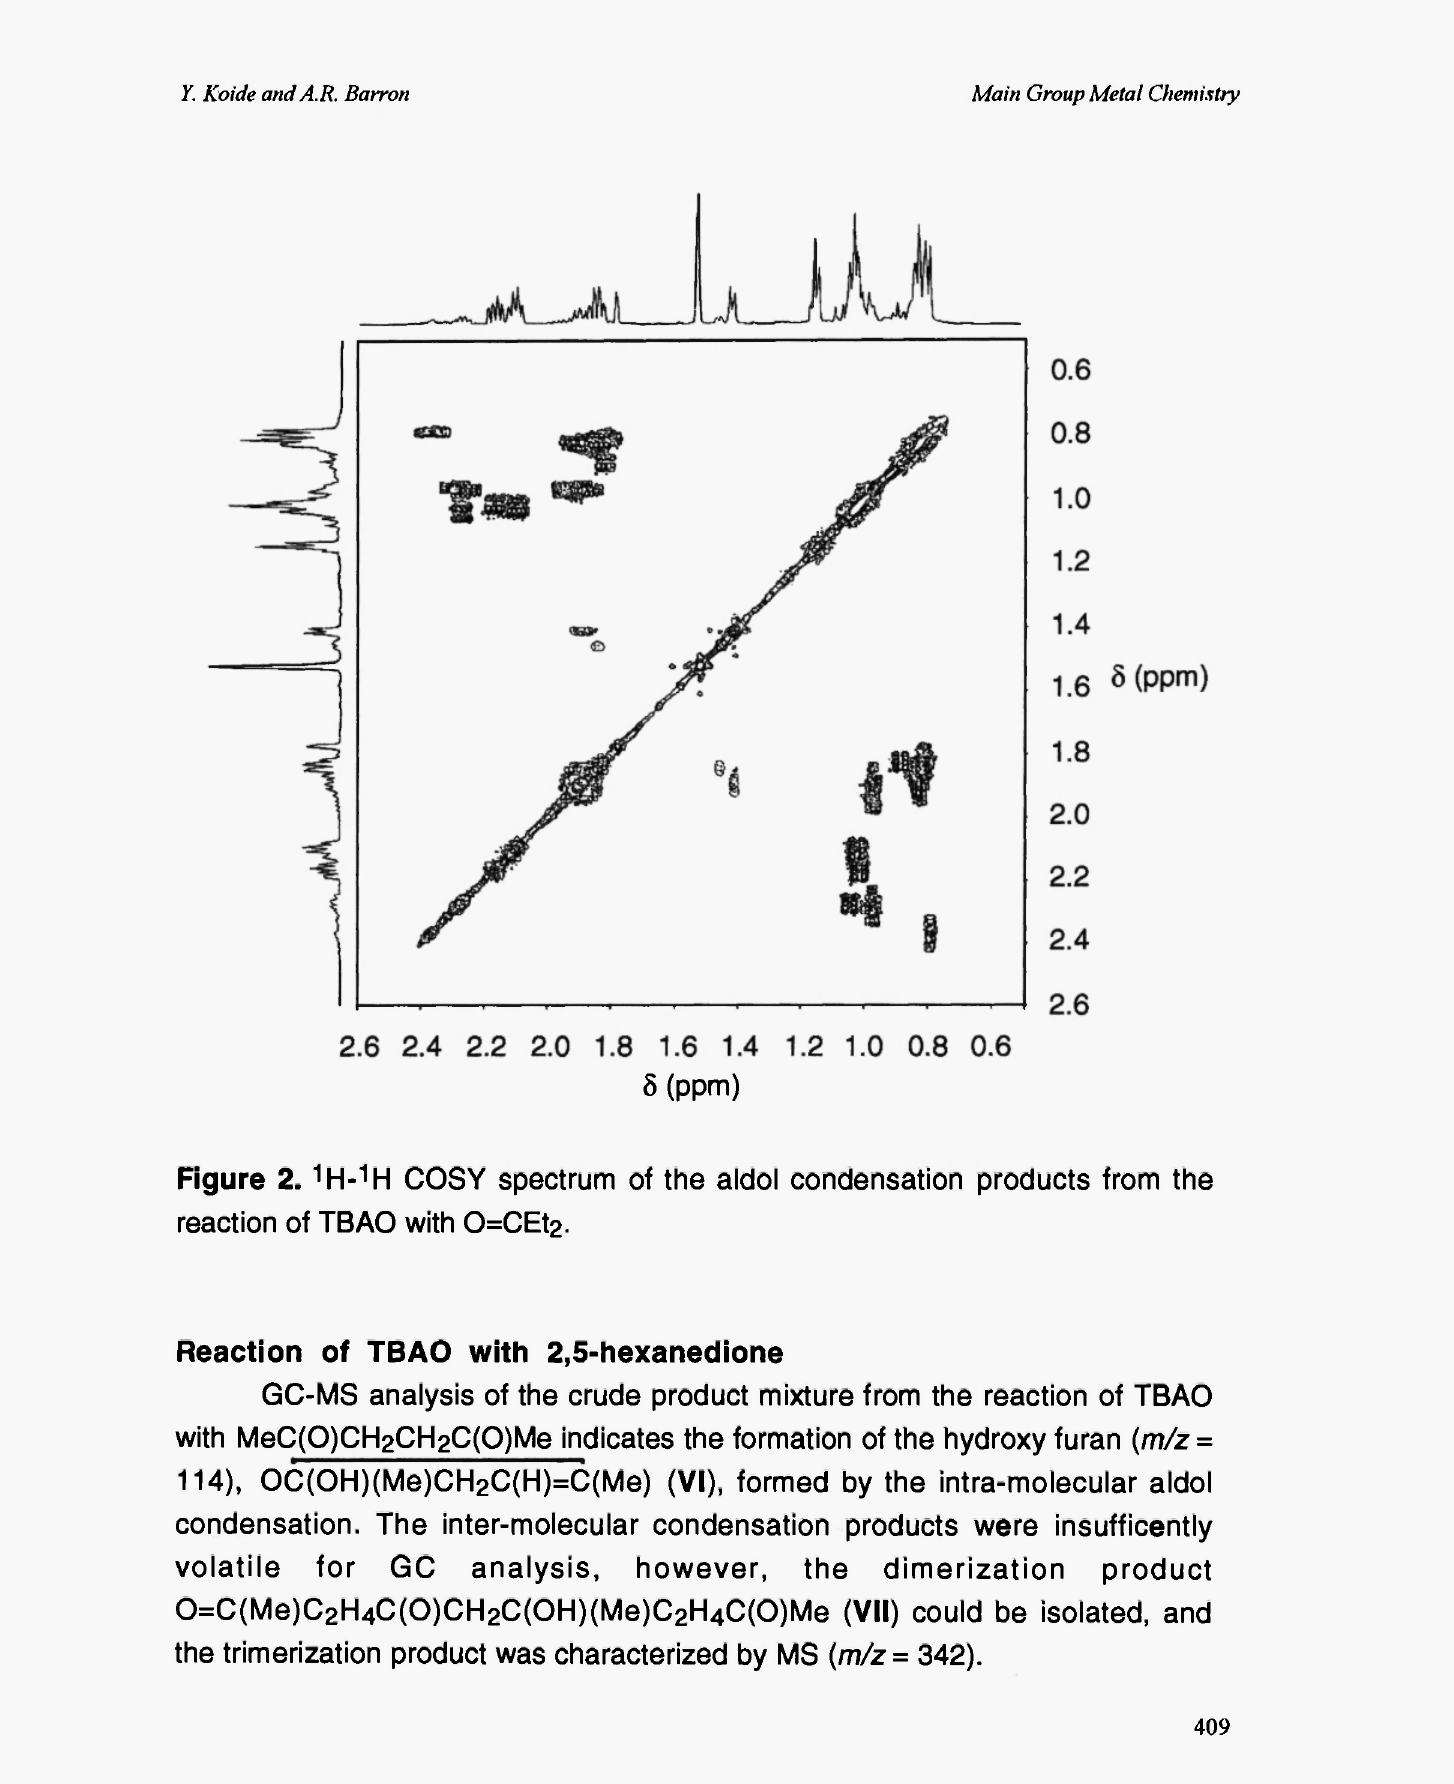
Reaction of TBAO with 2,5-hexanedione GC-MS analysis of the crude product mixture from the reaction of TBAO with MeC(Q)CH2CH2C(Q)Me indicates the formation of the hydroxy furan ( m/z = 114), OC(OH)(Me)CH C(H)=C(Me) (VI), formed by the intra-molecular aldol 2 condensation. The inter-molecular condensation products were insufficently volatile for GC analysis, however, the dimerization product 0=C(Me)C H4C(0)CH2C(0H)(Me)C H4C(0)Me (VII) could be isolated, and 2 2 the trimerization product was characterized by MS ( m/z =